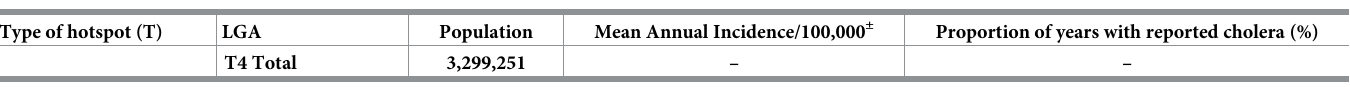
± Note: Table is arranged in descending order of mean annual incidence within the hotspots types (T). The Local Government Area (LGA) population reflects the year 2019 estimates.